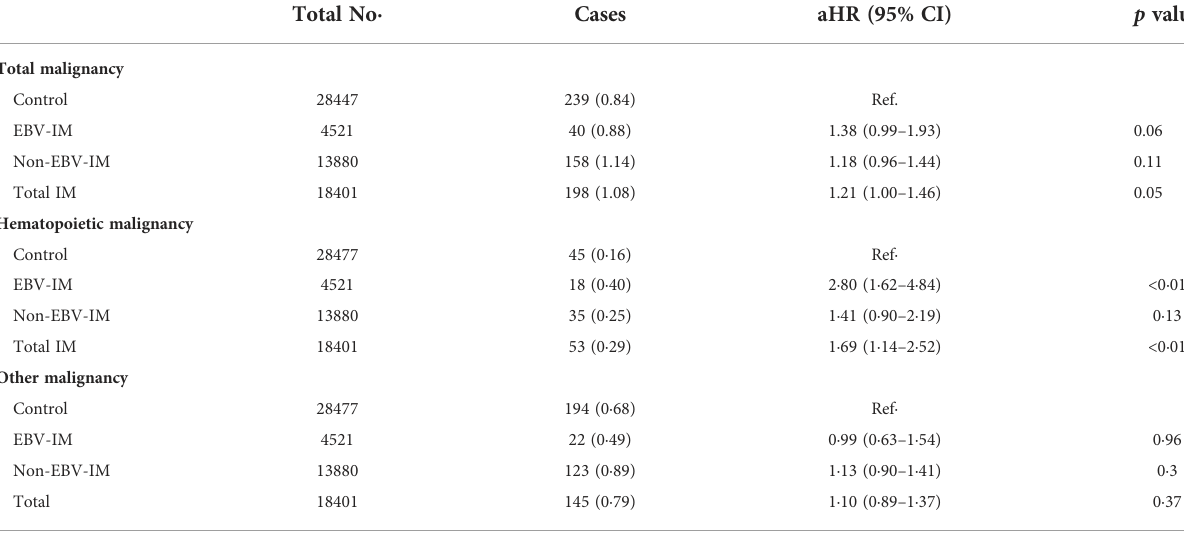
TABLE 3 Risks of subtypes of malignancy associated with Infectious Mononucleosis (IM) in sibling-matched